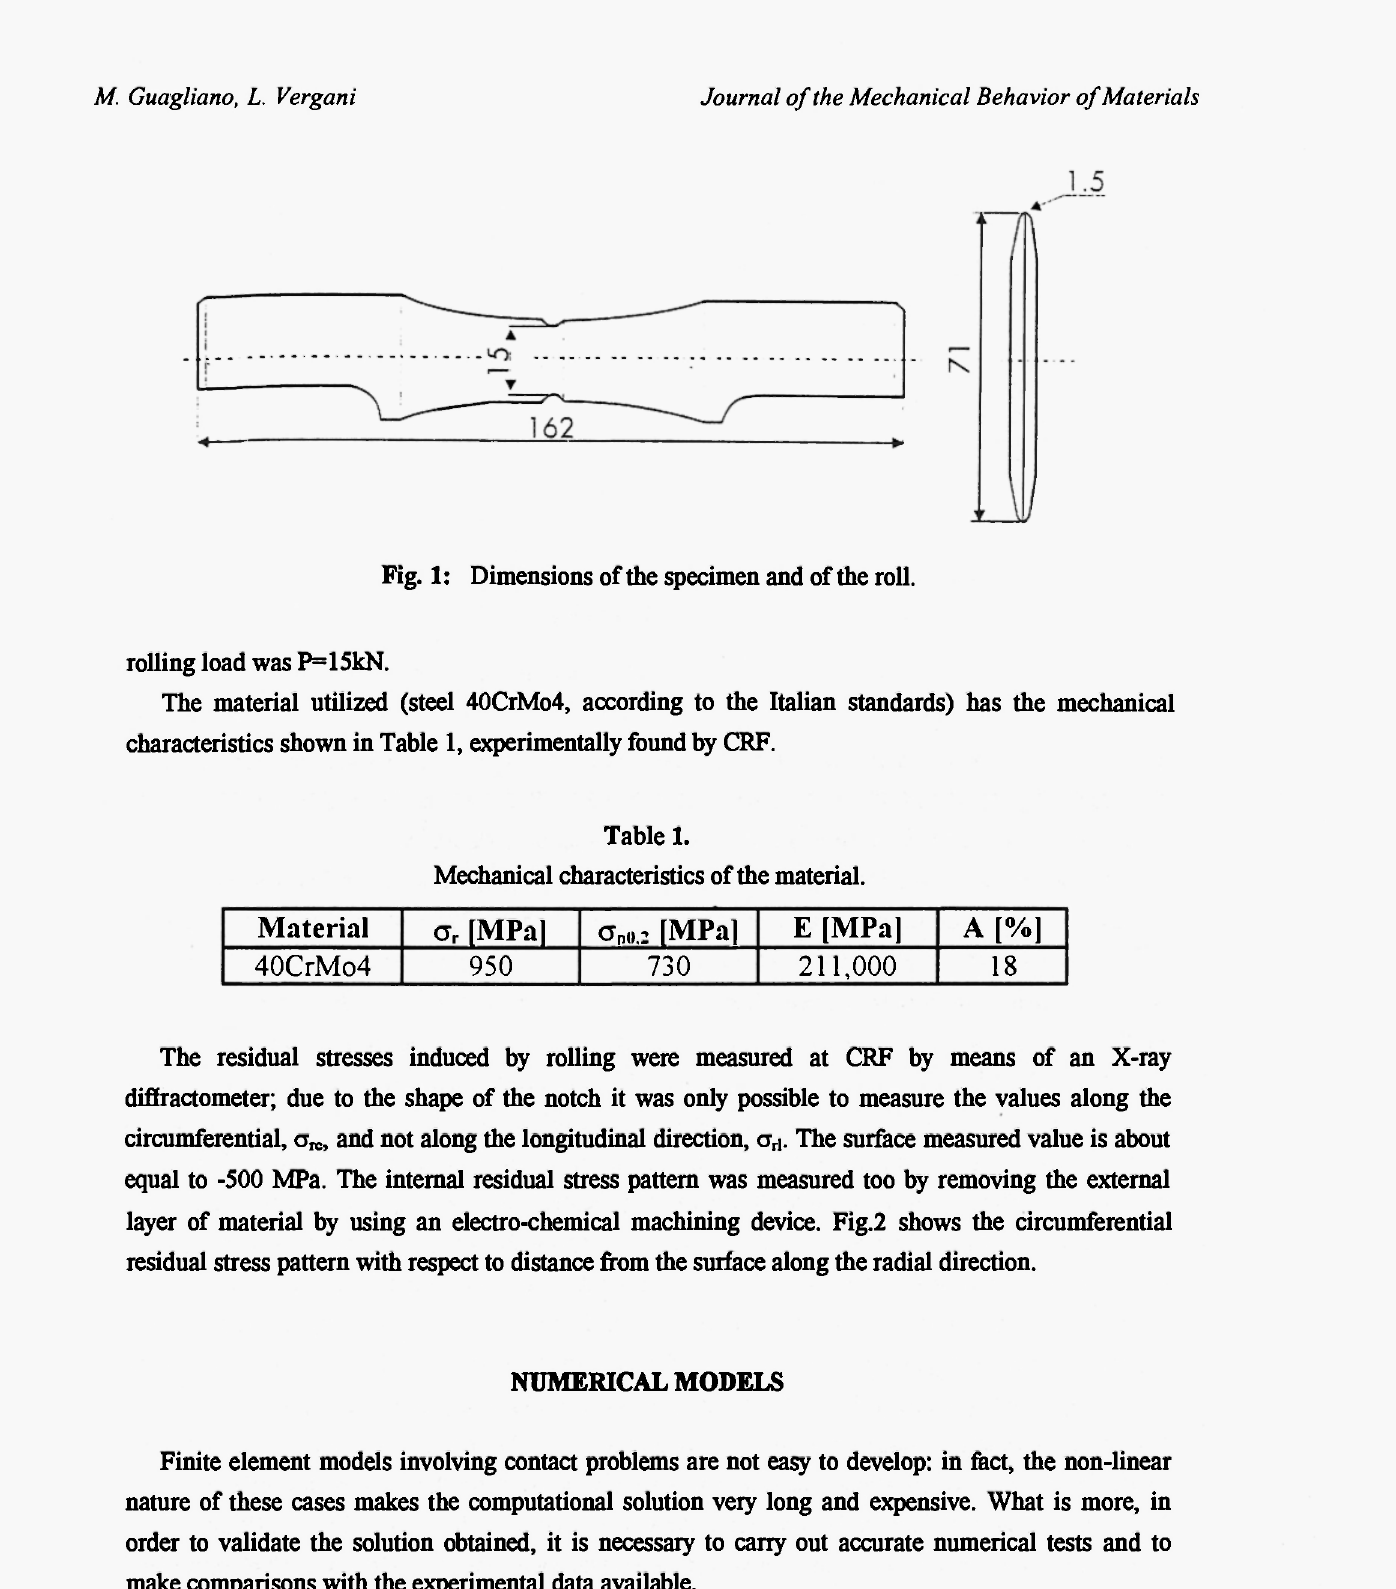
Fig. 1: Dimensions of the specimen and of the roll.